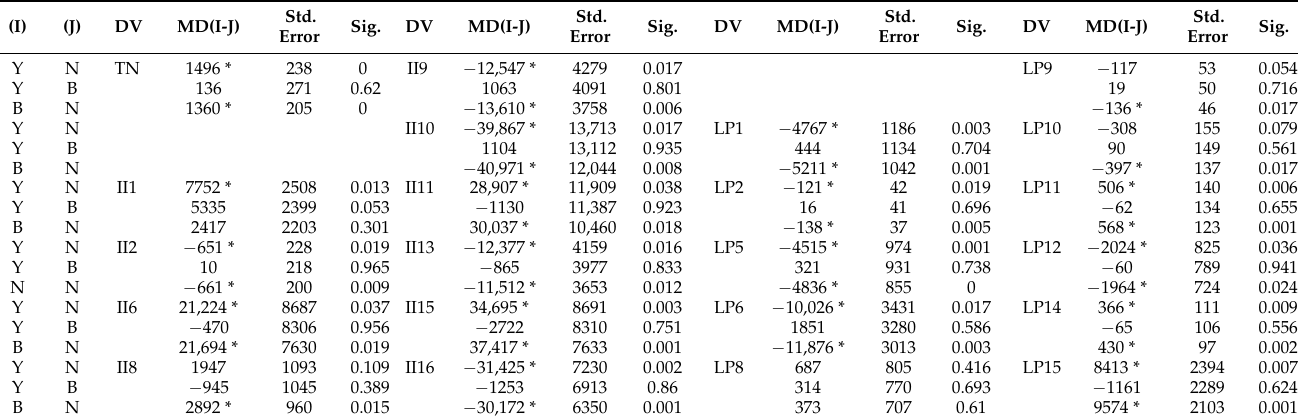
Table 4. Post hoc tests- multiple comparisons by